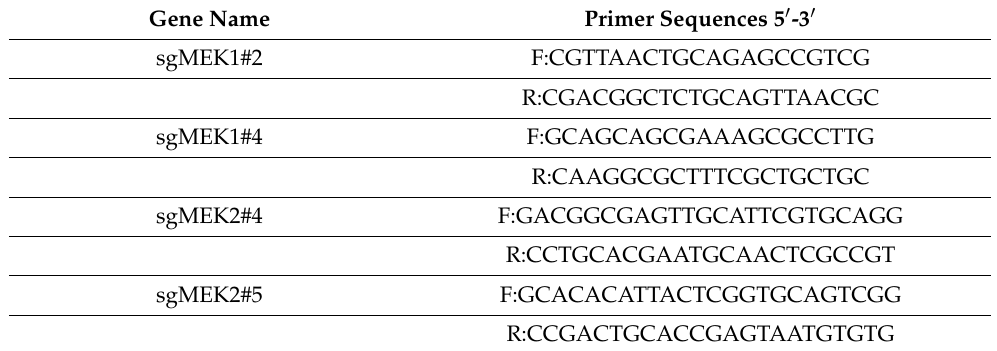
Table 1. The oligonucleotide sequences of MEK1 and MEK2 single guide (sg)